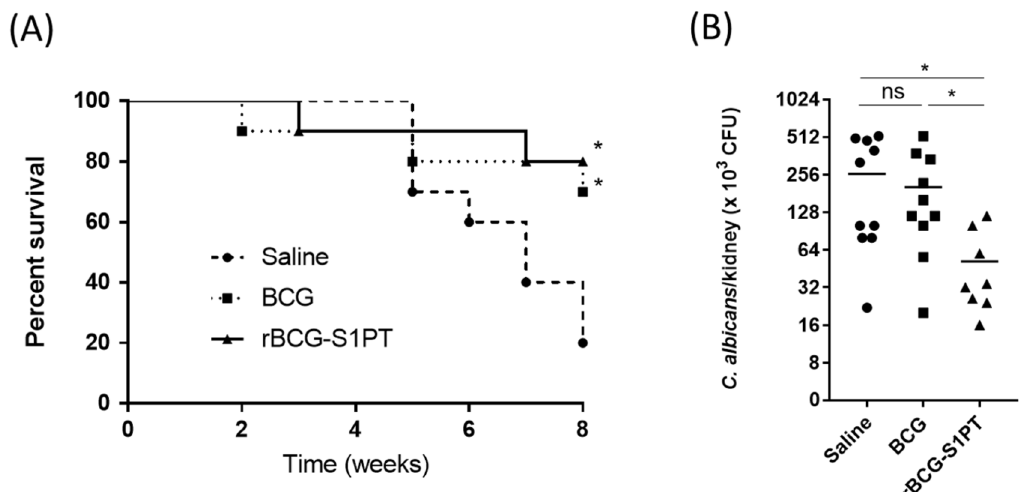
Figure 6. Priming with rBCG-S1PT increases the protection against C. albicans challenge. ( A ) Groups of SCID mice (n = 10/group) were primed with 10 6 CFU of BCG or rBCG-S1PT and challenged 2 weeks later with C. albicans . The mice were followed for survival for 8 weeks after infection. ( B ) Using other groups of mice (n = 5/group), kidneys were collected one week after the challenge, and C. albicans CFU was evaluated. The results are representative of two and three experiments, respectively. The statistical significance of survival was determined via Log-rank (Mantel-Cox) test, and CFU via Mann–Whitney U test. * p < 0.05 vs. saline control. ns = not significant. Bars represent the mean ± SEM of values from the kidneys of five